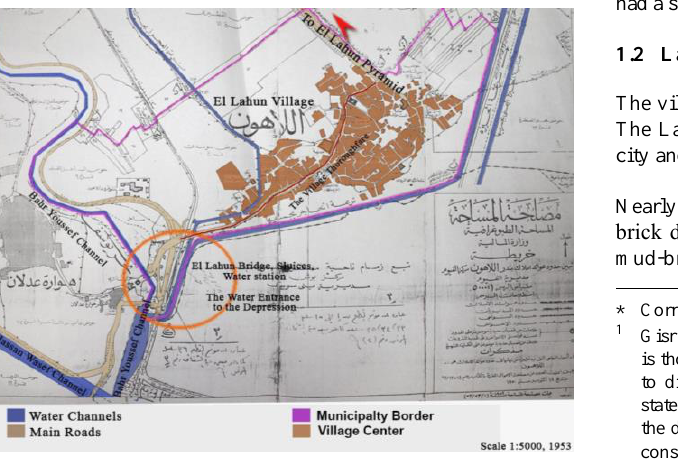
Figure 1. The Egyptian General Survey Authority Map of the Lahun Gap, (scale 1:5000,